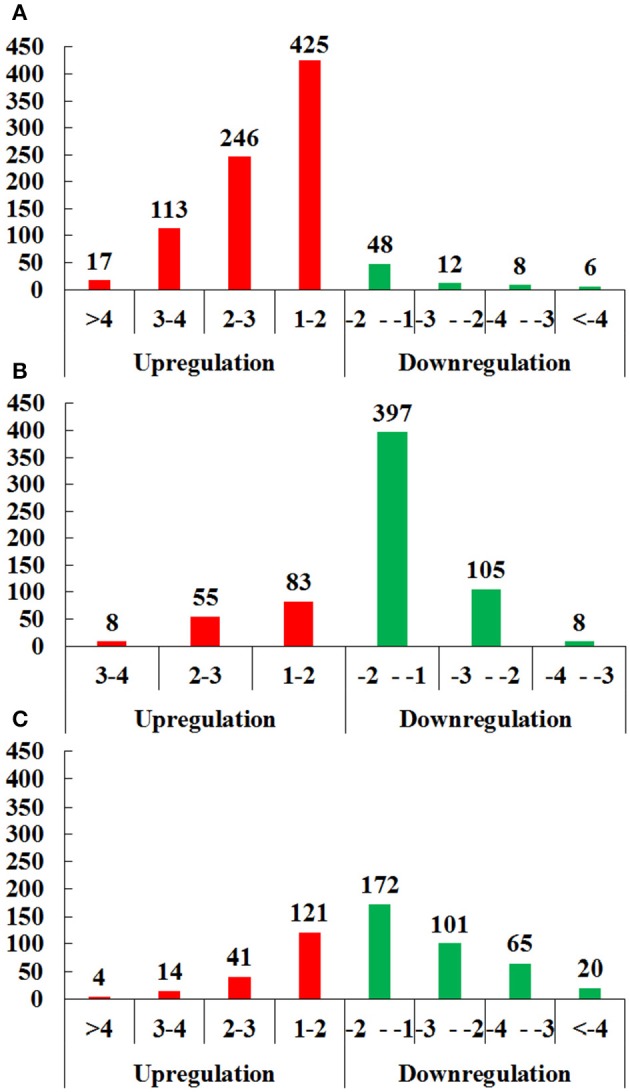
Distributions of differentially expressed proteins (DEPs) of O vs. T, T vs. C and C vs. O in different level of differentiation. (A–C) represent distributions of DEPs of O vs. T, T vs. C and C vs. O, respectively. The x-axis indicates values of log2 fold changes. The y-axis indicates the number of proteins. Red and green colors represent upregulated and downregulated DEPs. O, oocysts; T, tachyzoites; C, bradyzoites-containing cysts.